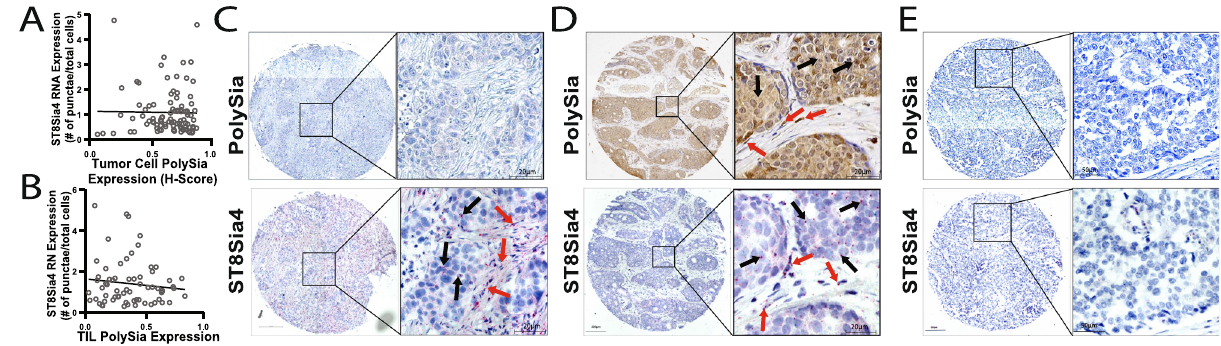
Fig. 3 PolySia and ST8Sia4 expression in tumor cells and tumor-in fi ltrating lymphocytes. A and B Correlation between tumor cell ( n = 93) ( A ) and ( B ) TIL ( n = 70) polySia expression levels plotted relative to ST8Sia4 expression levels for each matched tissue core. Gray line = Regression line. Pearson correlation test and simple linear regression test. C – E Representative images of polySia and ST8Sia4 expression serial sections. Zooms are of similar regions for each matched set. Arrows point to tumor cells (black arrows) and lymphocytes (red arrows) positive for polySia and/or ST8Sia4. Scale bar = 200 µm (cores) and 50 µm (Fig. 6A; p = 0.01, n = 106). Evaluation of CD56 expression levels relative to molecular subtype ( n = 106: Luminal A, n = 28; Luminal B, n = 35 HER2 + , n = 25; TNBC, n = 18) identi fi ed a signi fi cant